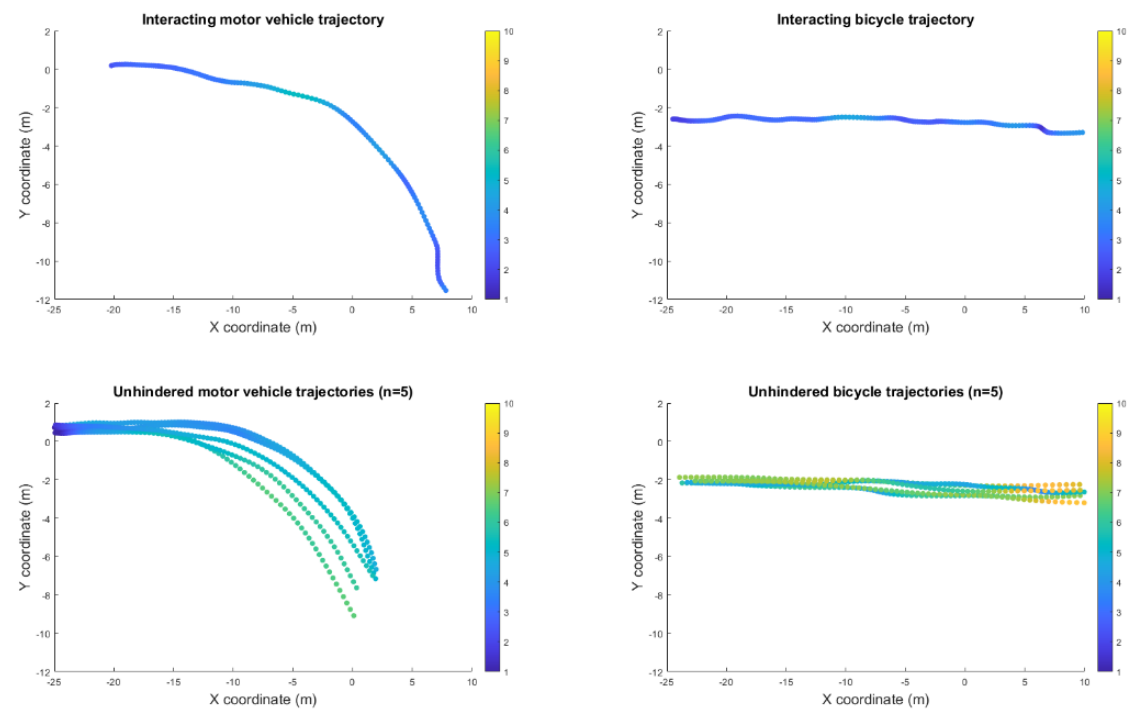
Figure 2 Trajectories from interacting motor vehicle and bicycle (top row) and a set of five unhin- dered motor vehicle and bicycle trajectories (bottom row); the colour bar shows speed in m/s The proposed method relies on two main definitions: ( i ) what an unhindered motion is and ( ii ) what is a proper measure of (un)similarity between two